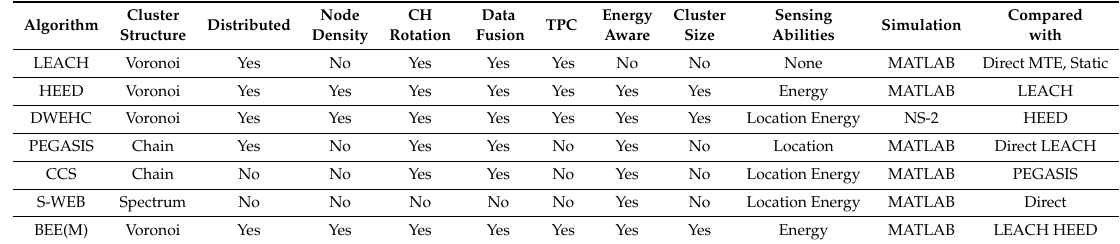
Table 1. Comparison of 6 Existing Clustering Algorithms and BEE(M).